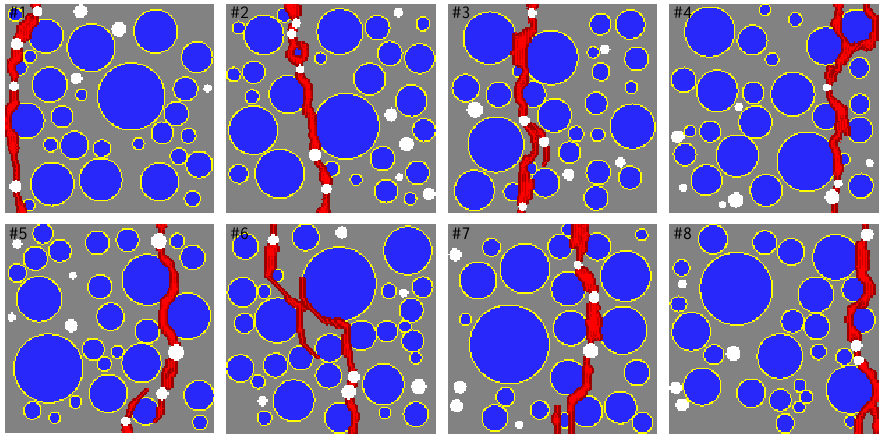
Figure 16. Crack pattern for selected specimens with P pore = 2% and P agg =